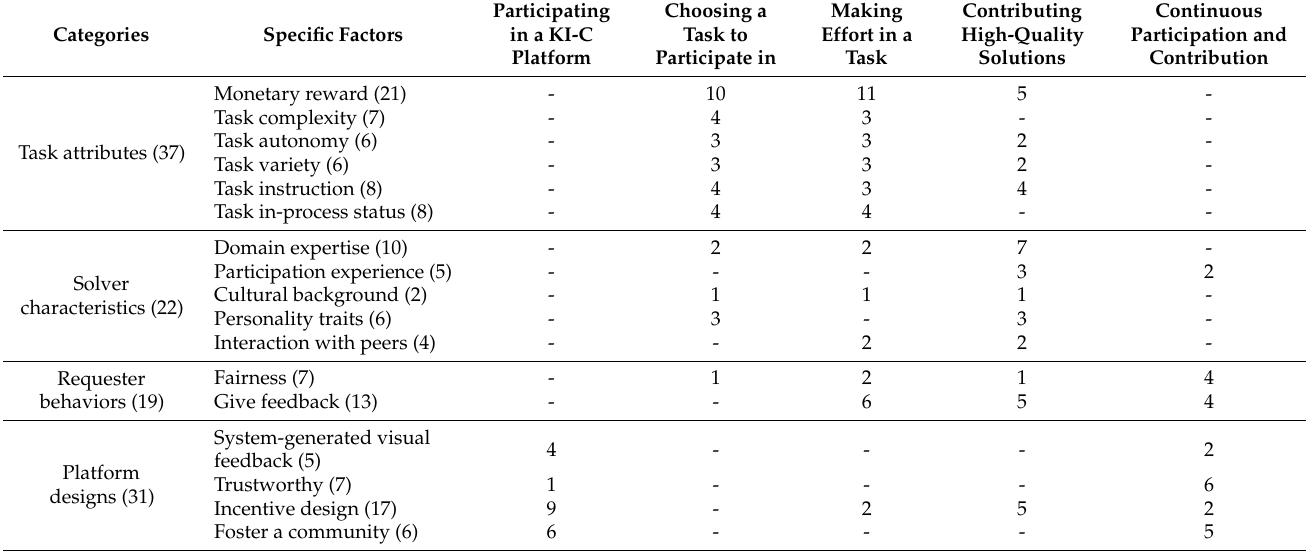
Table 3. The factors influencing the solvers’ behaviors in